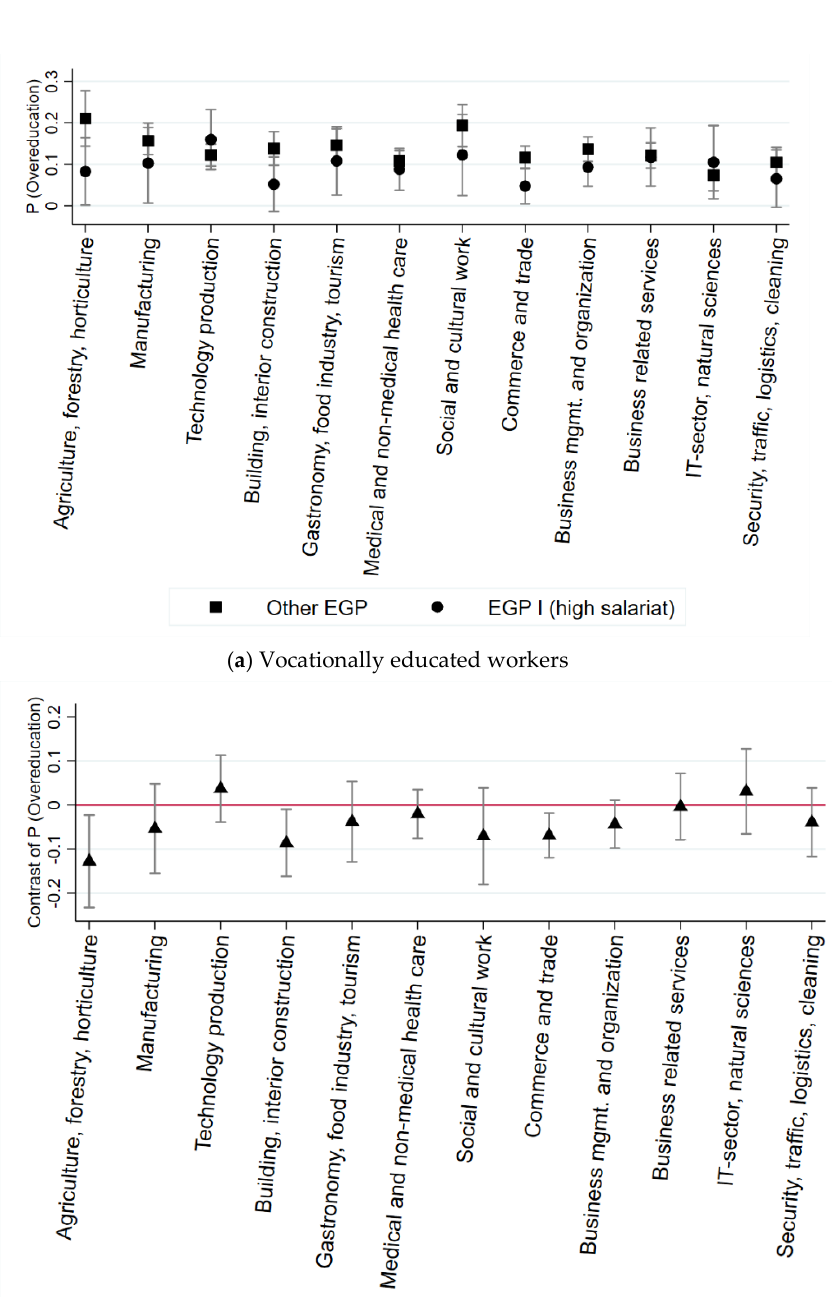
Figure A2. ( a ) Predicted probability of overeducation (objective indicator) (AME) within vocational education for each combination of educational field and social background; ( b ) Social background differences (EGP I high salariat-other EGP) of predicted probability of overeducation. Confidence intervals at 95-percent level. Weighted results. Data: BIBB/BAuA Employment Survey 2018, authors’ own calculations.